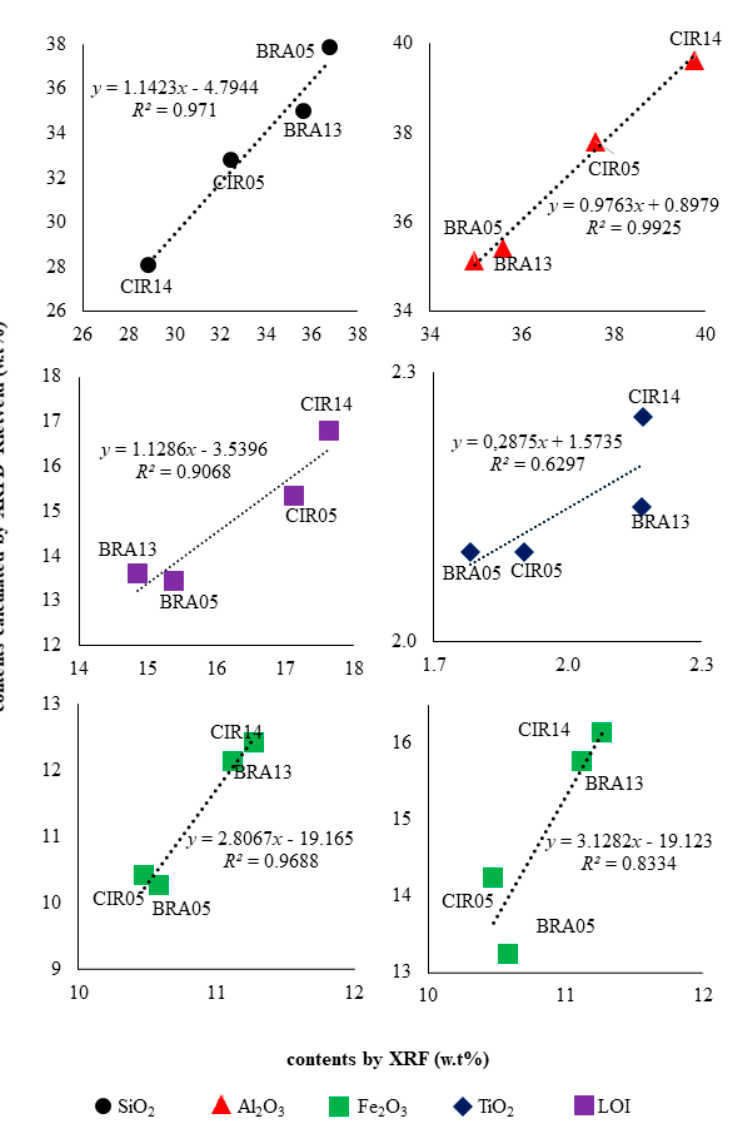
Figure 10. Comparison of the chemical composition measured by XRF and calculated after the Rietveld analysis.